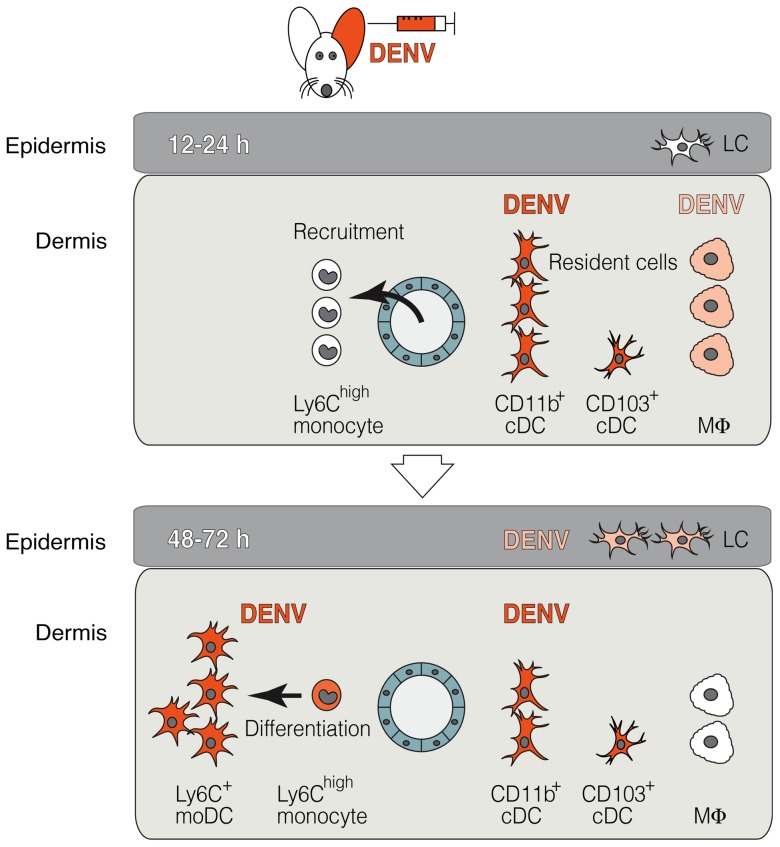
The two waves of DENV infection in the skin.Using a novel i.d. DENV infection model in the ear of Ifnar
–/– mice, DENV was shown to initially infect resident cells of the dermis, most importantly Ly6C– CD11b+ cDCs at 12–24 hpi. DENV also infects dermal CD103+ cDCs and to a lower extent MΦs, which decrease in frequency compared to steady state (top panel). At the same time, Ly6Chigh monocytes are recruited from the blood to the DENV-infected dermis, where they differentiate to Ly6C+ CD11b+ moDCs, which become the major targets for DENV infection in a second wave of replication between 48–72 hpi (bottom panel). DENV infects approximately 100-fold more hematopoietic cells in the dermis than LCs in the epidermis.